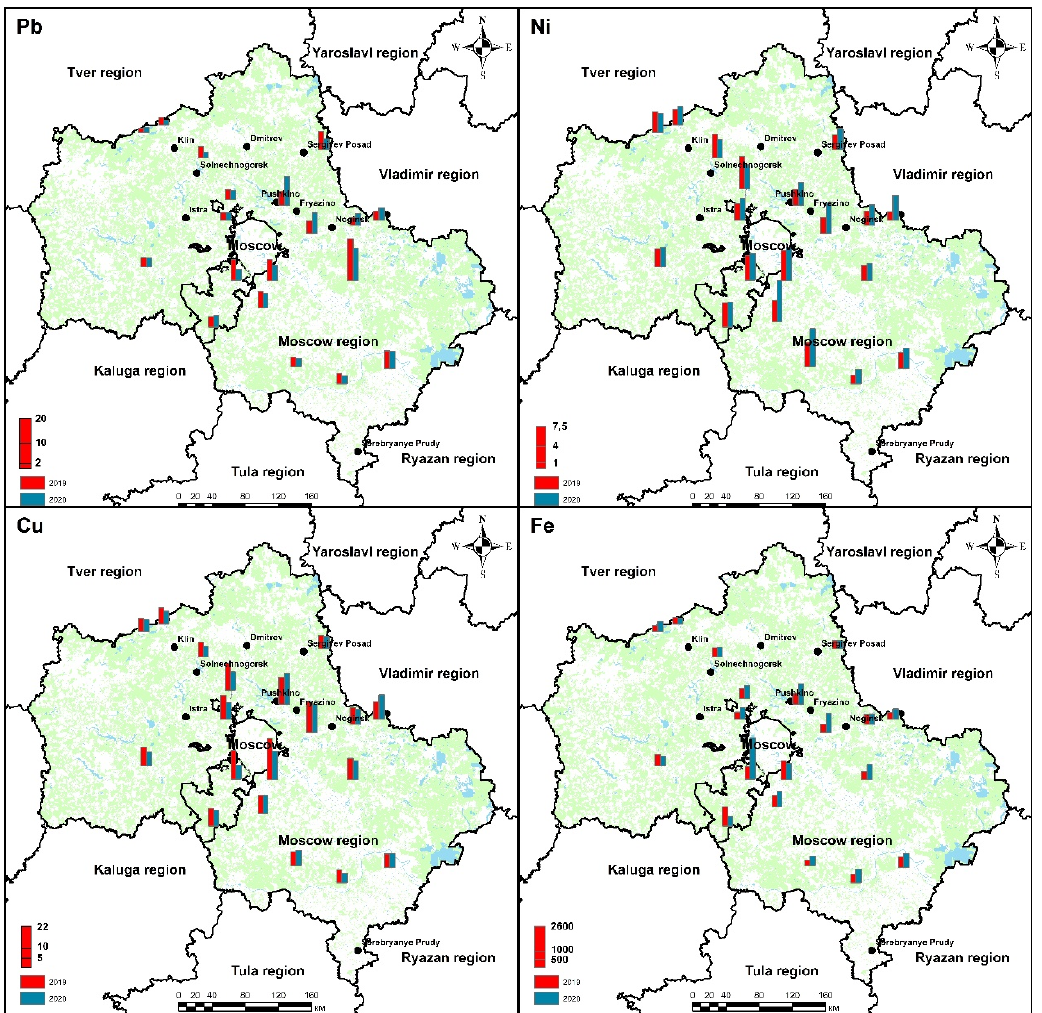
Figure 2. Maps of element content in moss samples collected in 2019 and 2020 in the Moscow region (in mg/kg d.w).